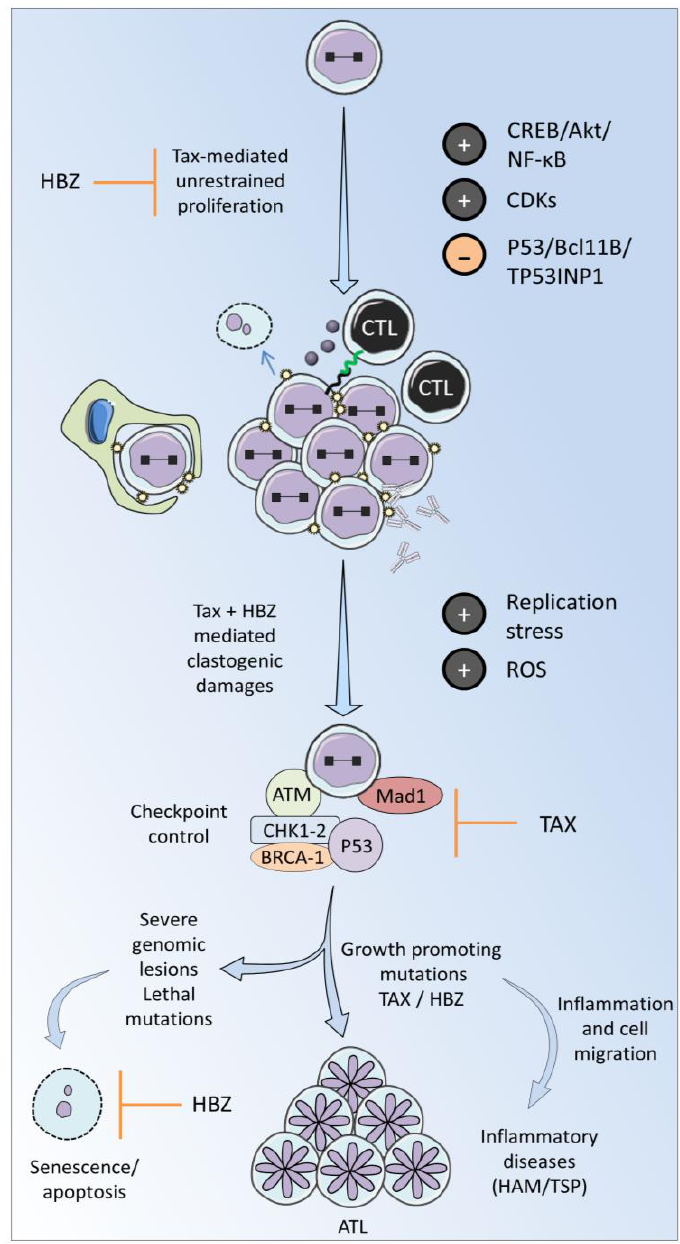
Figure 2. Tax and HBZ promote proliferation and persistence of the infected cell. Tax activates survival pathways (CREB/Akt/NFkB), promotes mitosis (CDKs), and inhibits tumor suppressors (p53, TP53INP1, Bcl11B). Tax-mediated growth-promoting activities are counteracted by HBZ, mitigating unrestrained proliferation. The host immune response further controls infected cell proliferation. Tax-induced proliferation creates replicative stress and generates reactive oxygen species (ROS). Tax interacts with the mitotic checkpoint control protein Mad1 thereby inducing clastogenic damage. Tax attenuates the DNA damage response (DDR) induced by unscheduled cell proliferation. Inhibition of the DDR allows cells to accumulate DNA lesions and stabilize mutations. If uncontrolled by senescence or cell death mechanisms, growth-promoting mutations pave the way to disease development.